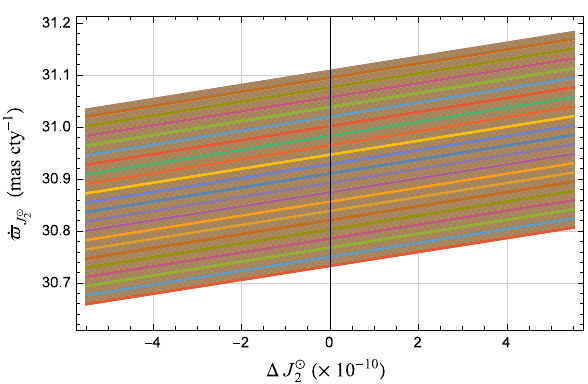
(cid:2) ; (cid:8)(cid:6) (cid:3) , (cid:8) i (cid:3) (cid:8) J (cid:3) J (cid:3) 2 2